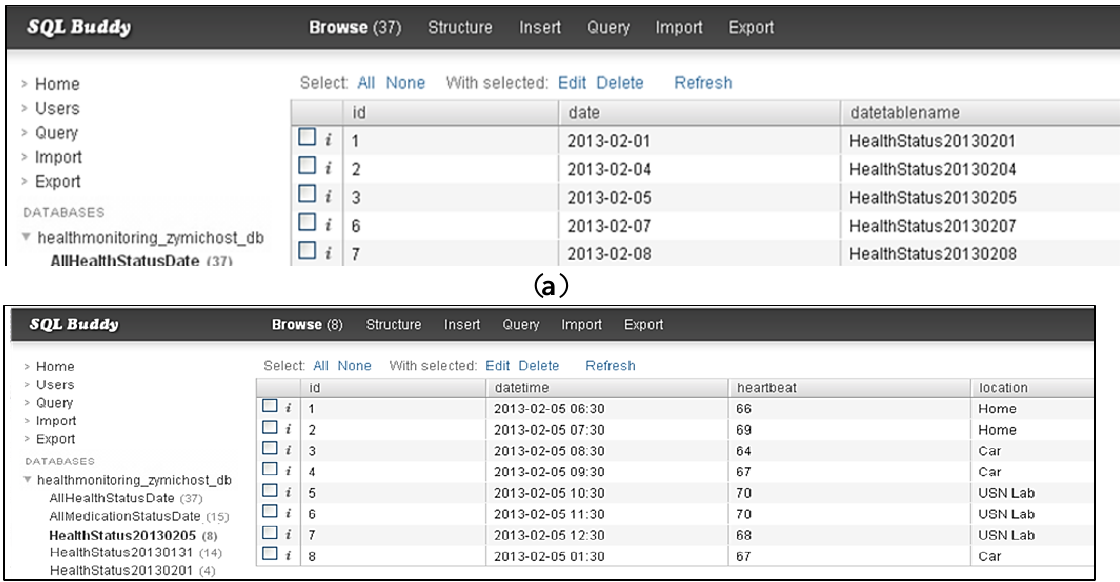
of health data between Web server database and the Web page. HR is synchronized in